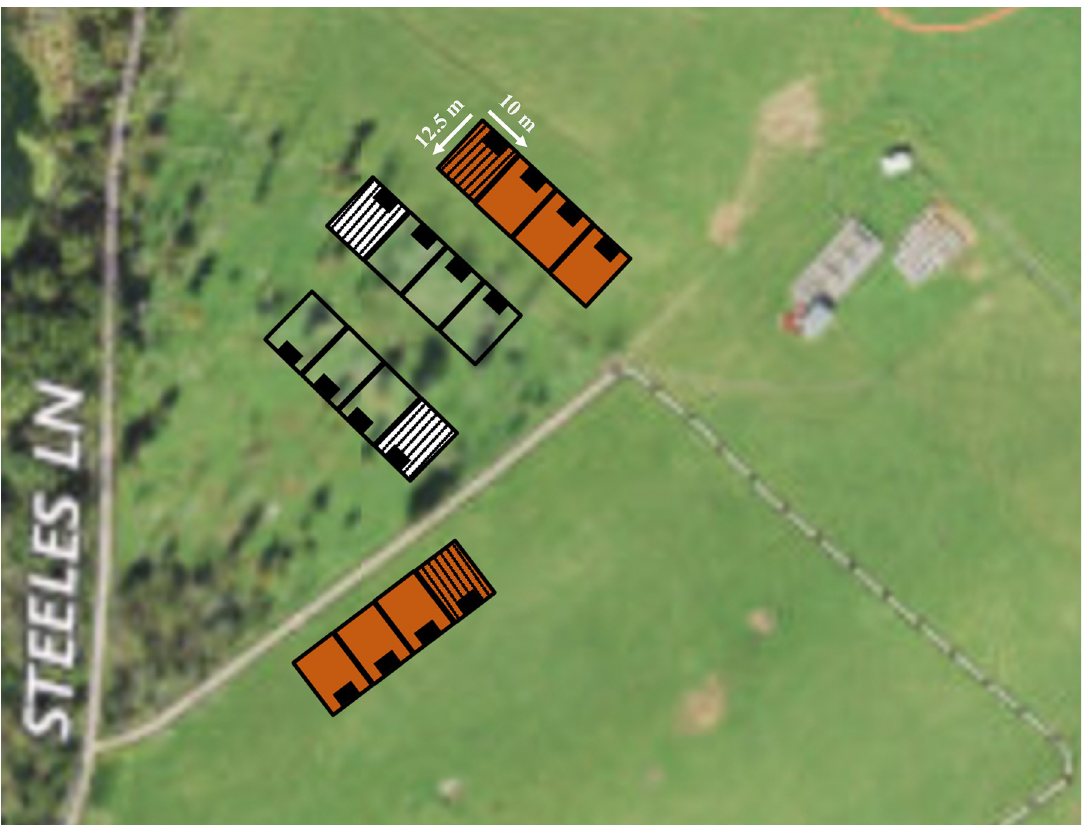
Fig 1. Image and illustration of experimental plots (125m 2 each). Open grassland pasture plots (orange) and silvopasture plots (black/ white) contained a chicken coop (black). Experiment 1 included 4 replicates per treatment in two locations, and Experiment 2 included 3 replicates per treatment in two locations. The omitted replicate plots for Experiment 2 are marked with a pattern fill. Map sourced from USGS National Map